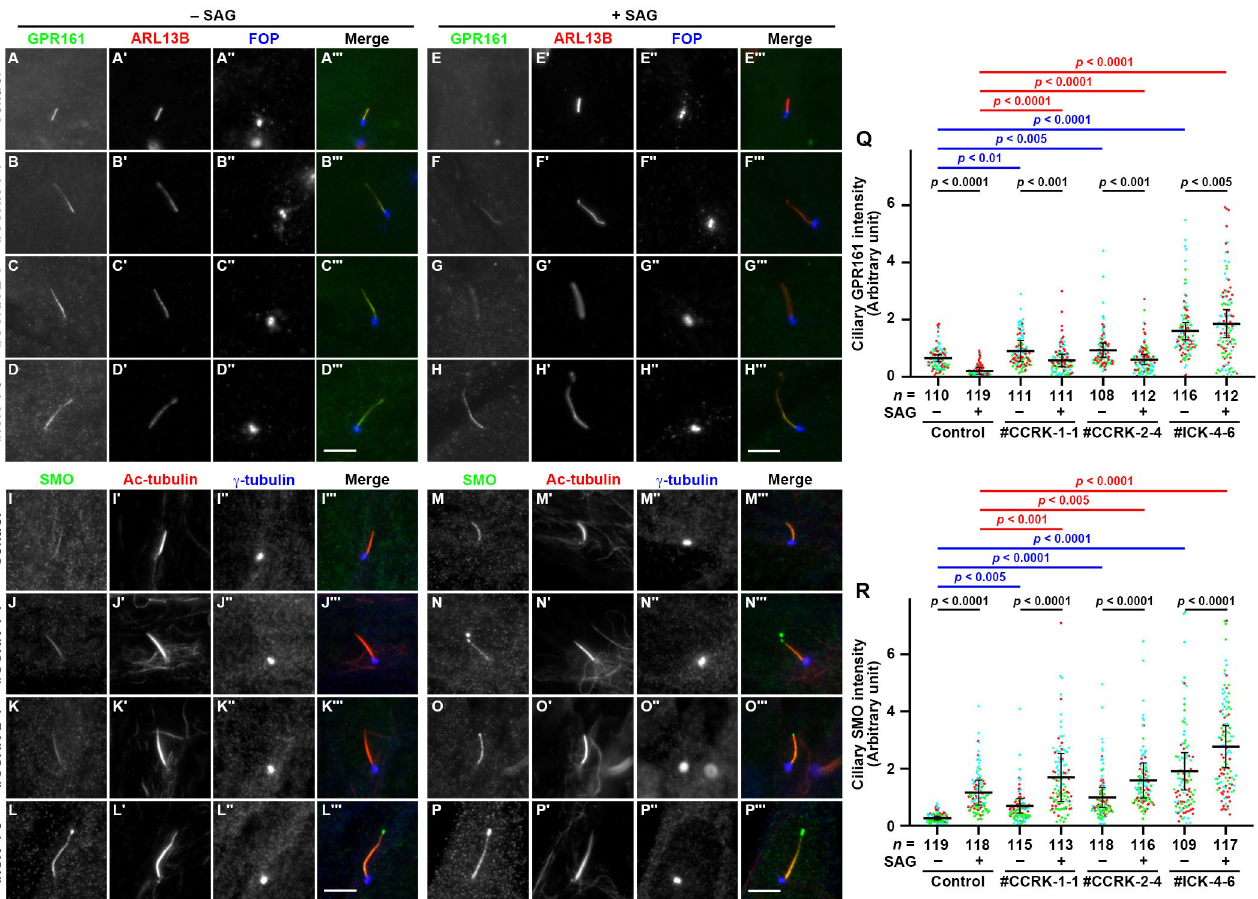
Fig 4. Accumulation of GPR161 and SMO within cilia in CCRK -KO cells. (A–P) Control RPE1 cells (A, E, I, M), the CCRK -KO cell lines #CCRK-1-1 (B, F, J, N) and #CCRK-2-4 (C, G, K, O), and the ICK -KO cell line #ICK-4-6 (D, H, L, P) were serum-starved for 24 h, and further incubated for 24 h without ( − SAG; A–D, I–L) or with (+SAG; E–H, M–P) 200 nM SAG. The cells were triple immunostained for GPR161 (A–H), ARL13B (A 0 –H 0 ), and FOP (A 00 –H 00 ), or for SMO (I–P), Ac-tubulin (I 0 –P 0 ), and γ -tubulin (I 00 –P 00 ). Scale bars, 5 μ m. (Q, R) The relative ciliary staining intensities of GPR161 and SMO shown in (A–H) and (I–P), respectively, were estimated and expressed as scatter plots. The total number of cells analyzed ( n ) are indicated. In the scatter plots, different colored dots represent three independent experiments, horizontal lines indicate the means, and error bars are the SDs. Statistical significances among multiple cell lines were calculated using one-way ANOVA followed by the Tukey multiple comparison test, and those between two groups ( − SAG and +SAG) were calculated using the Bonferroni-adjusted Student t -test. basal ciliary level of GPR161 was significantly higher in CCRK -KO and ICK -KO cells than in